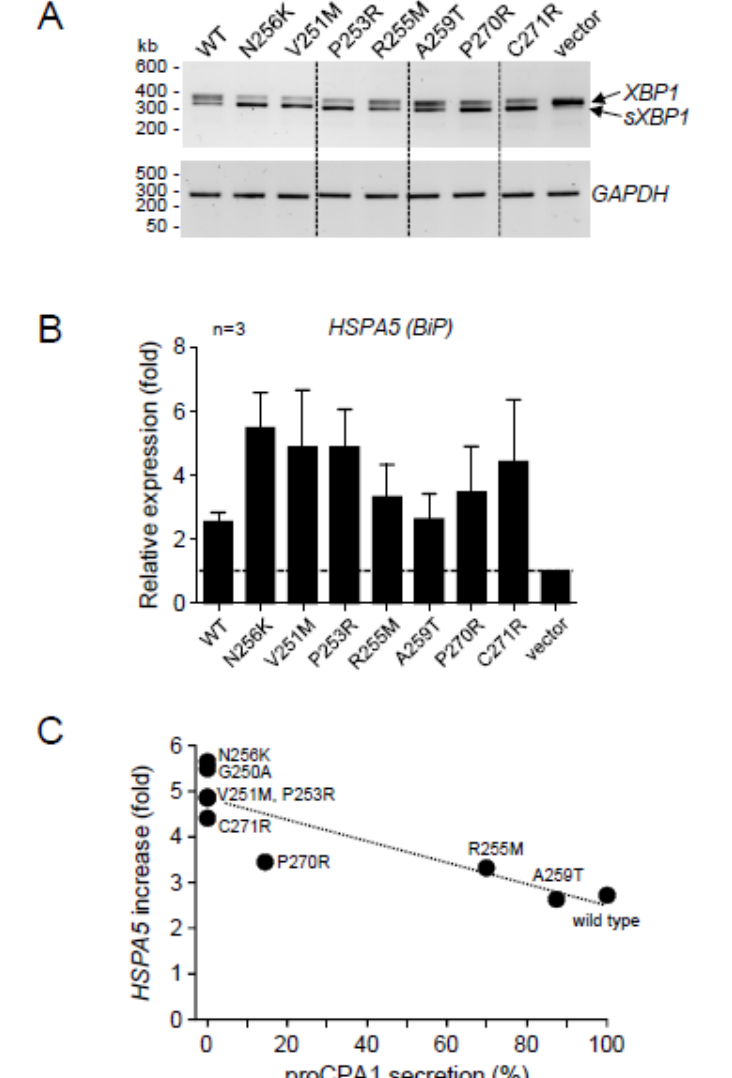
Figure 5. Effect of natural CPA1 variants on endoplasmic reticulum stress markers in transfected HEK 293T cells. ( A ) Splicing of XBP1 mRNA ( sXBP1 ) assessed by RT-PCR and agarose gel electrophoresis. GAPDH mRNA was measured as a loading control. Representative gel from two experiments is shown. ( B ) Expression of HSPA5 (BiP) mRNA measured by RT-qPCR. ( C ) Relationship between proCPA1 secretion and HSPA5 (BiP) mRNA levels. WT,